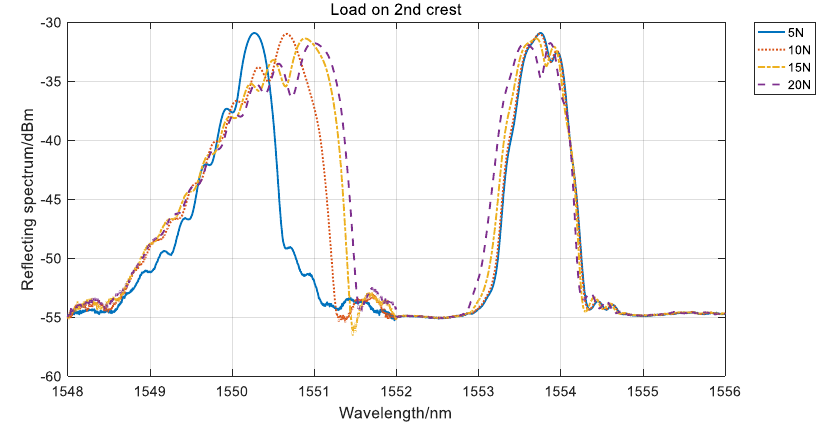
Figure 4. Reflecting spectrum of loads on the second crest.